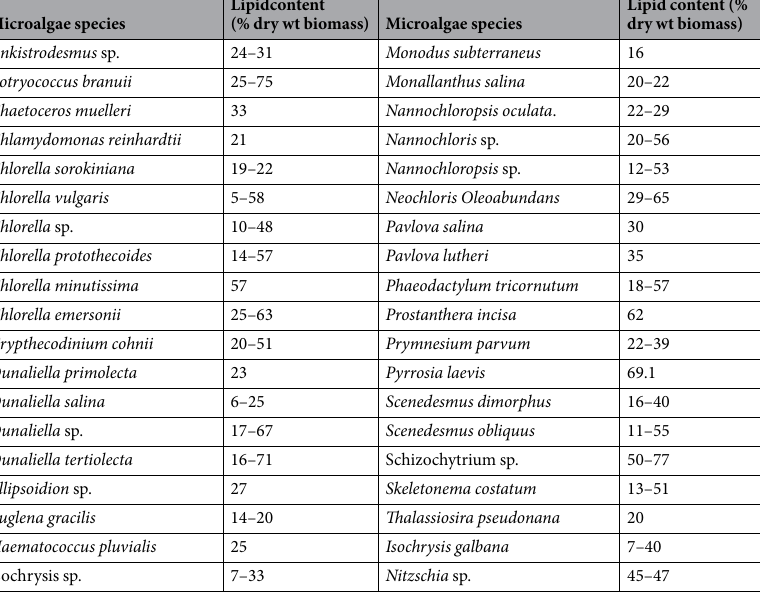
Table 2. Lipid content of different microalgae species 12, 13, 20–22